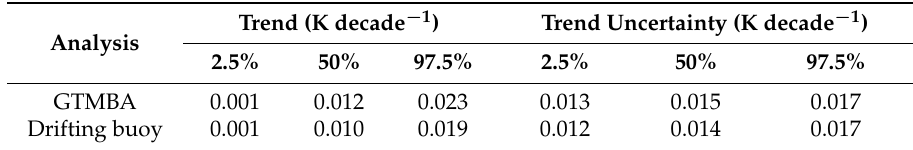
Table 8. Trend and trend uncertainty estimates for the AR1 model applied to the GTMBA and drifting buoy